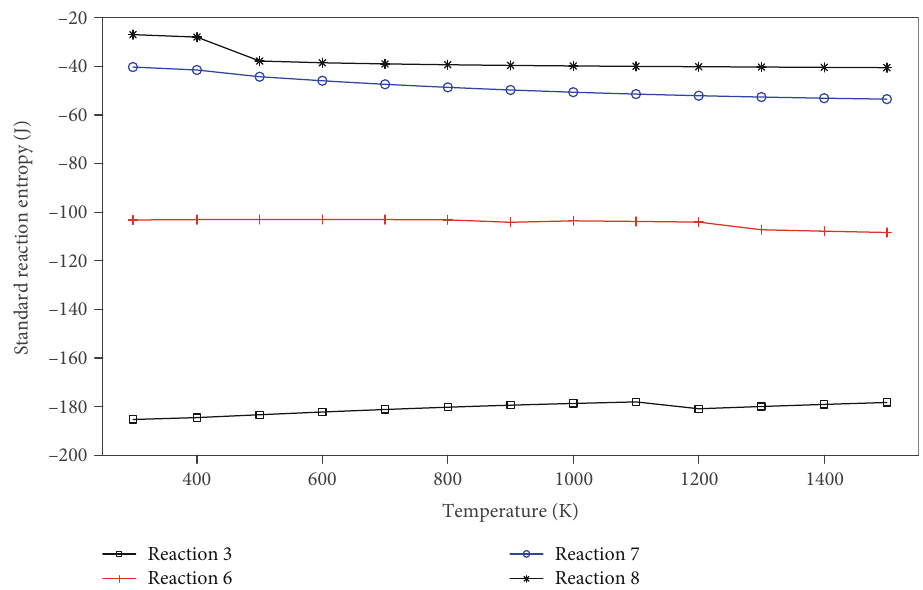
Figure 4: Standard reaction entropy di ff erence at di ff erent temperatures.